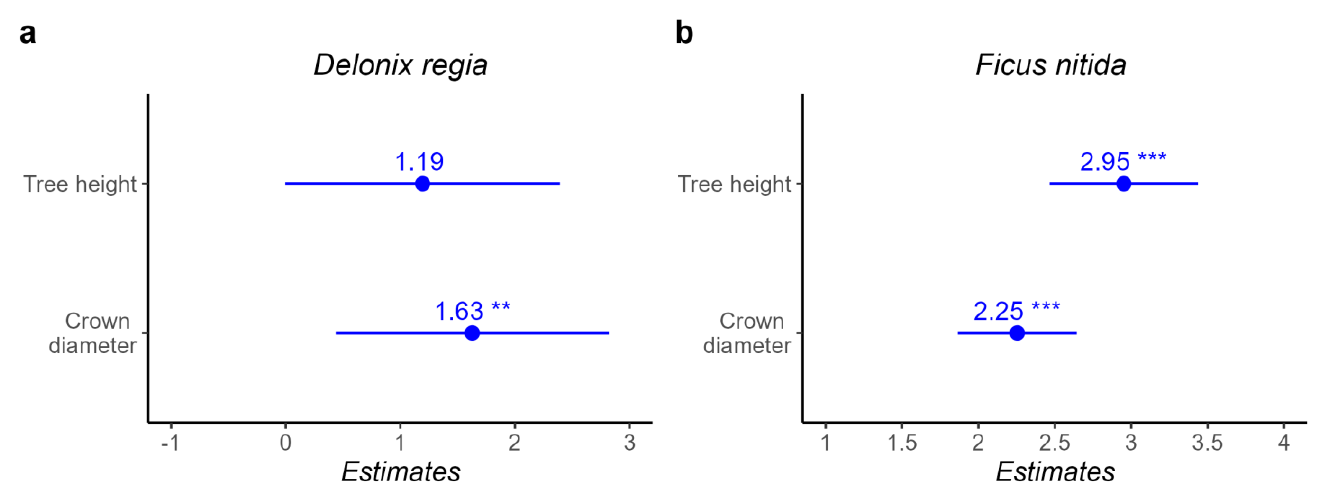
Figure 4. Impact of the tree structure variables on shaded area of three tree species in three plots using a linear mixed model. D. regia ( a ), F. nitida ( b ), with fixed effects of tree species, and random effects accounting for tree pit surface area and tree planting site. the p -value (with levels of significance indicated by symbols such as *** and **) for each ANOVA shows the significant impact of the tree structure variables and shaded area for the species.